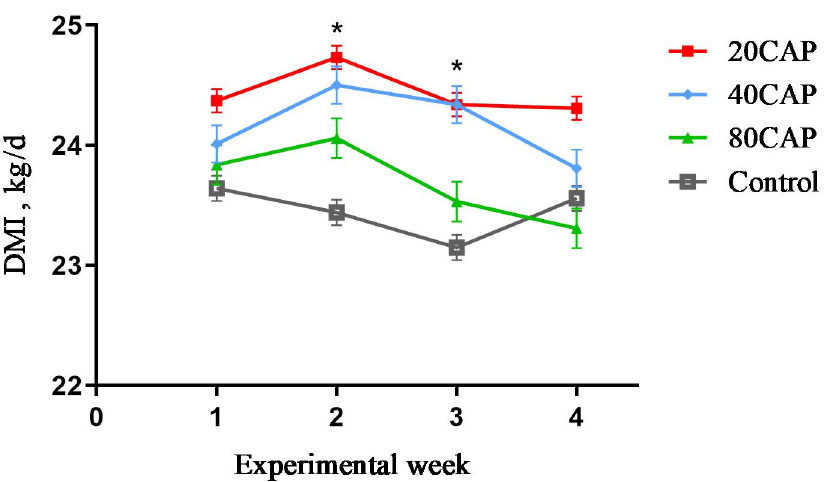
Figure 1. Change in average dry matter intake (DMI) throughout the study period in dairy cows that were fed a basal diet (control) or a basal diet supplemented with 20 (20CAP), 40 (40CAP), or 80 (80CAP) mg of CAP/kg of dry matter. Bars indicate the standard errors. Linear effect, p = 0.01; week effect, p < 0.01; week x treatment effect, p = 0.24. * indicates linear effect ( p < 0.05).